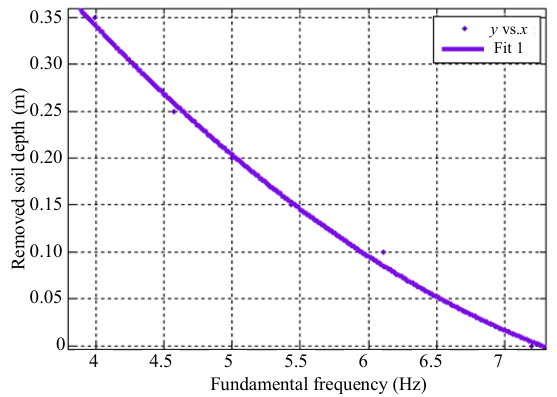
Fig. 11 Relationship between removed depth and